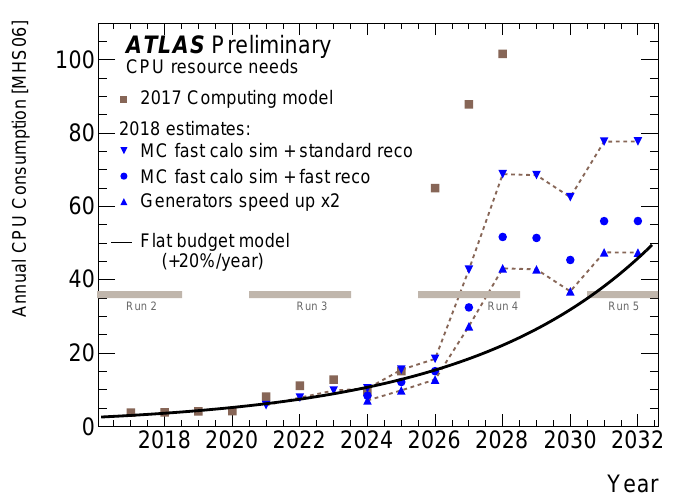
Figure 1: Estimated CPU resources (in MHS06) needed for the years 2018 to 2032 for both data and simulation processing. The plot updates the projection made in 2017 (which was based on the Run 2 computing model) with updated LHC running conditions and revised scenarios for future computing models